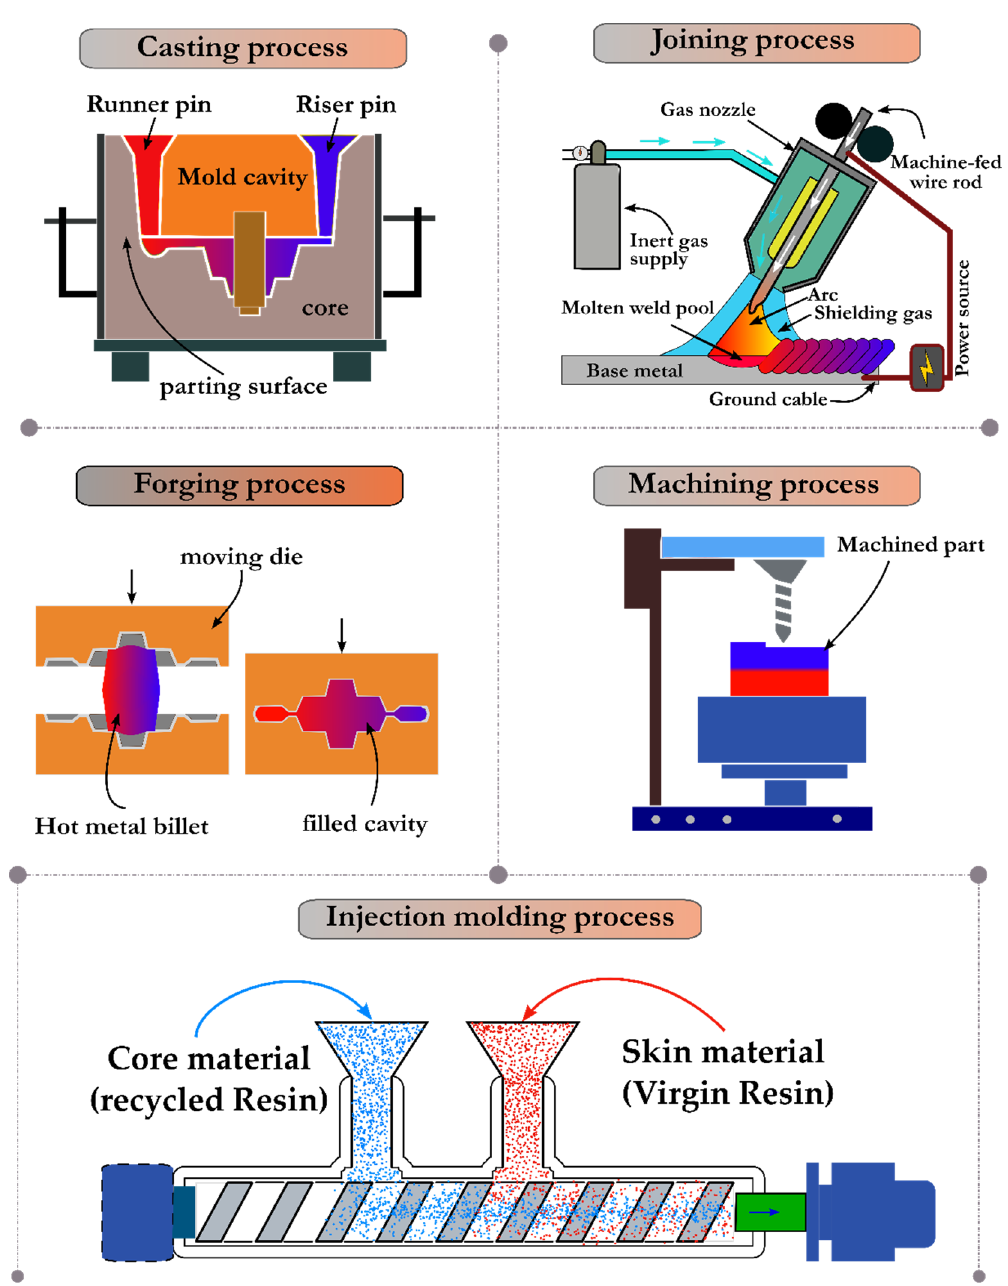
Figure 3. Schematic of casting, joining, forging, machining and injection molding processes.